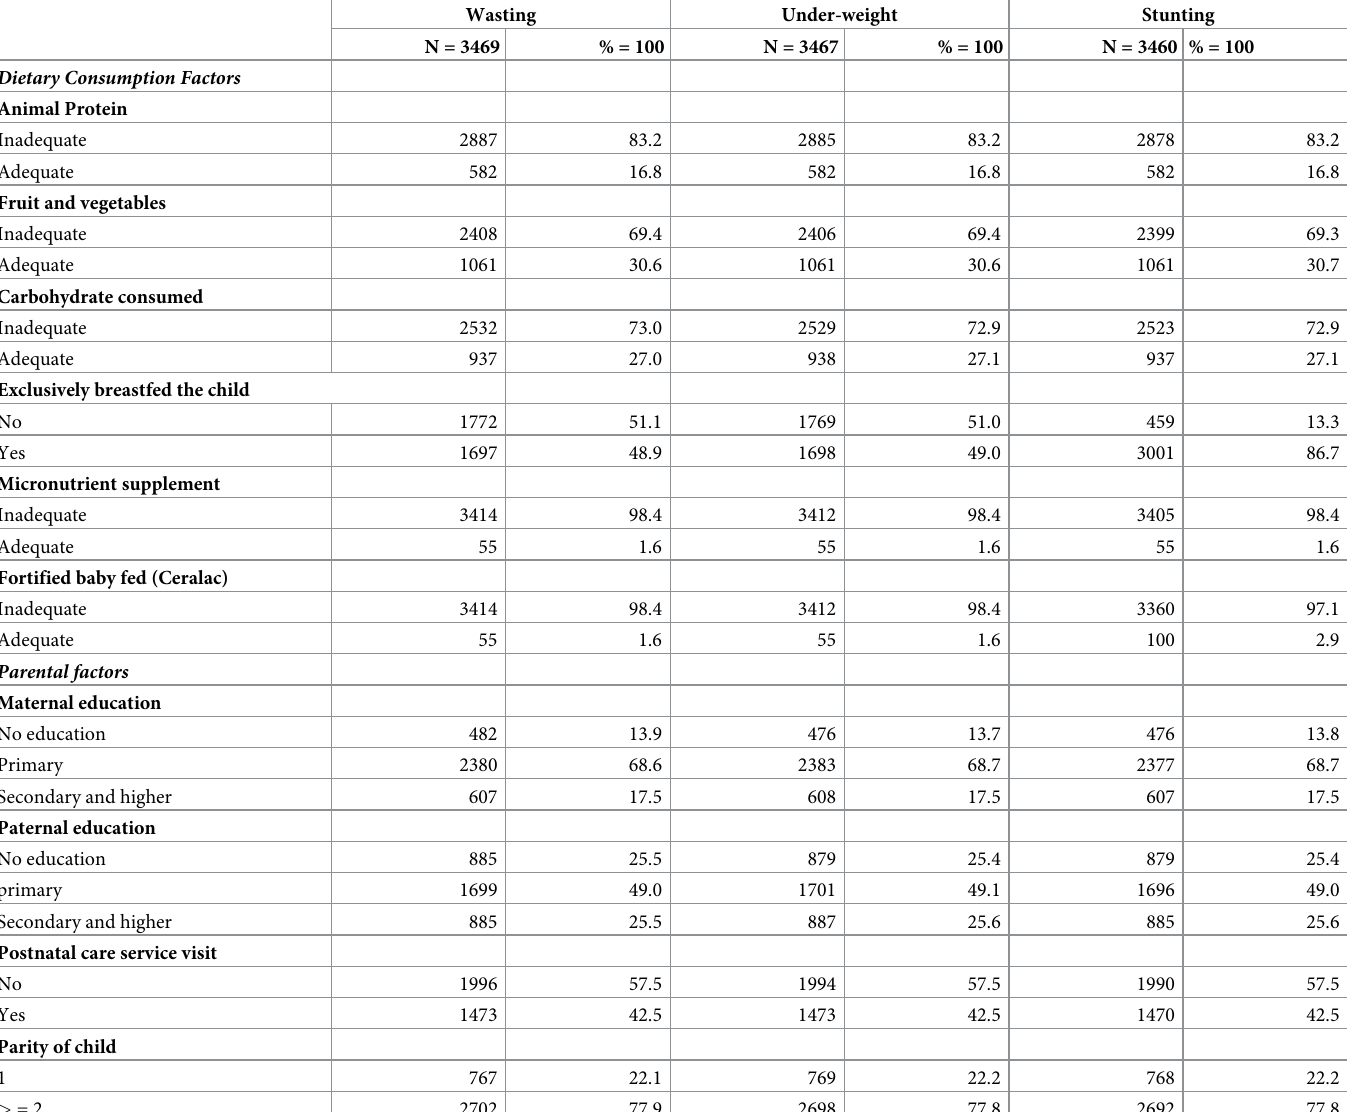
Table 1. Background characteristics by nutritional status of rural children